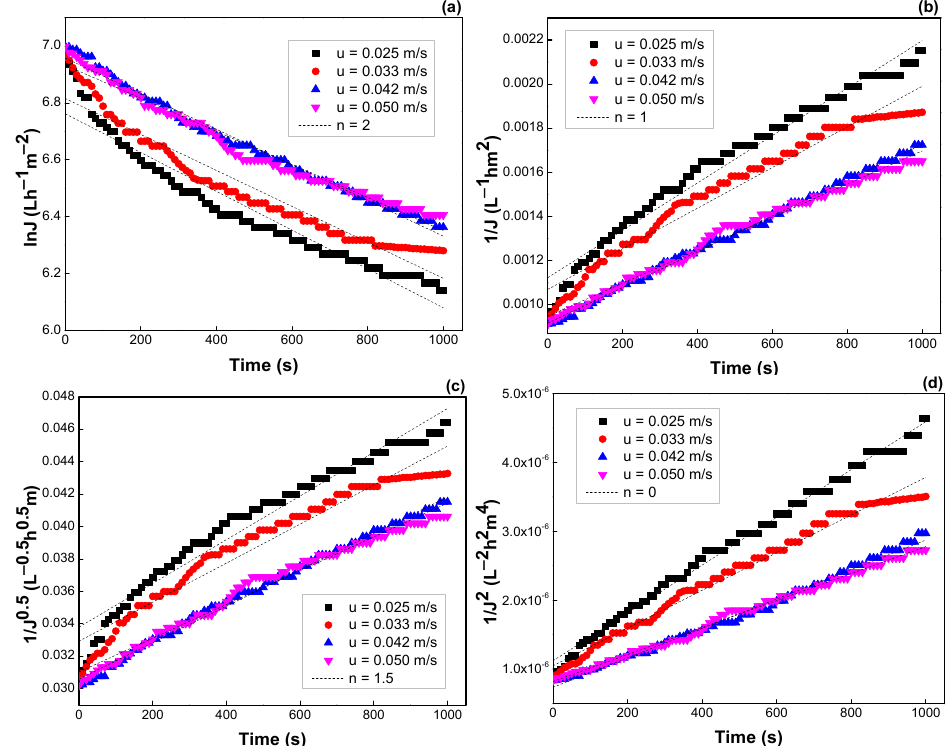
Figure 12. Effect of cross-flow velocity on the flux predicted by the Hermia model: ( a ) n = 2, ( b ) n = 1, ( c ) n = 1.5, and ( d ) n = 0 (see Table 3).